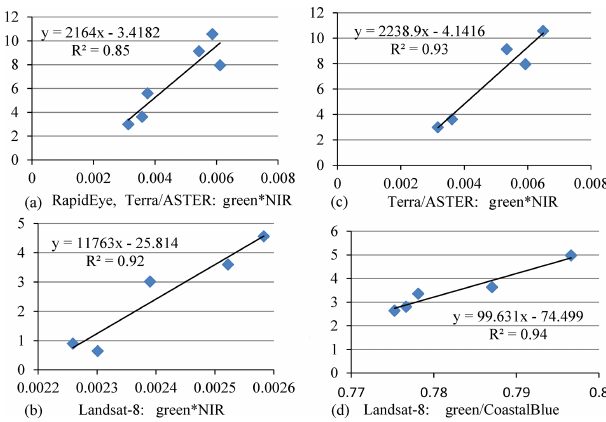
Figure 1. Regression dependences of in-situ data and satellite ob- servations: (a–c) CHL concentrations, mgm − 3 , (d) DOM absorp- tion coefficient, 1m − 1 .